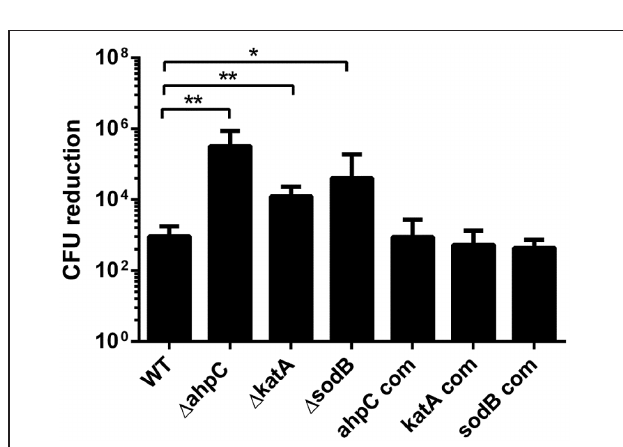
FIGURE 2 | Growth defects in the ahpC, katA, and sodB mutants under aerobic conditions. The results show the means and SD of the levels of CFU reduction in triplicate samples after 12 h culture under aerobic conditions. The ahpC com, katA com, and sodB com are complementation strains of ahpC , katA , and sodB , respectively. The experiment was repeated three times and produced similar reduction patterns. The initial CFU levels were approximately 10 9 CFU ml − 1 in all the tested stains. Statistical analysis was conducted by using the Student’s t -test. ∗ P ≤ 0.05, ∗∗ P <